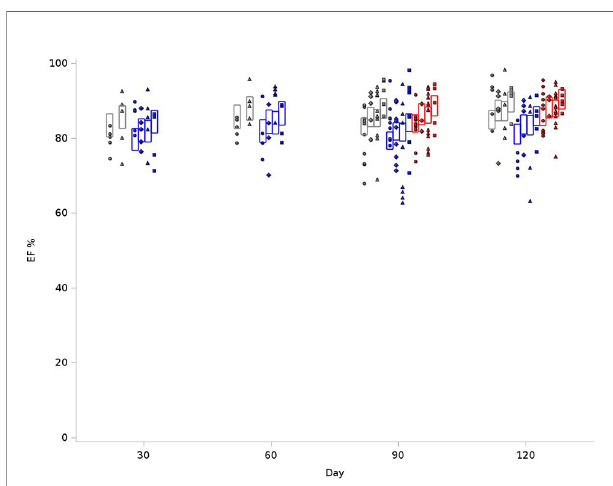
FIGURE 3 | Graphical representation of values for Ejection Fraction (EF) in rats at 4 time points (X-axis). The EFs were measured at 30, 60, 90 and 120 days. The values observed are represented by symbols denoting the experimental treatment: Circle (No Radiation and No Lisinopril -R-L), Diamond (No Radiation and Lisinopril -R+L), Triangle (Radiation and No Lisinopril +R-L), or Square (Radiation and Lisinopril +R+L). The colors represent the strain: Brown-Norway (BN: black), Salt-Sensitive (SS: blue) and SS with BN chromosome 6 (SSBN6: red). The rectangles are 95% Con fi dence Intervals for EF from a Repeated Measures linear model for treatment that included time and strain. EFs in SS rats were lower than those of other strains (p- value=0.002). They increase with Lisinopril (p-value=0.02) and also with radiotherapy